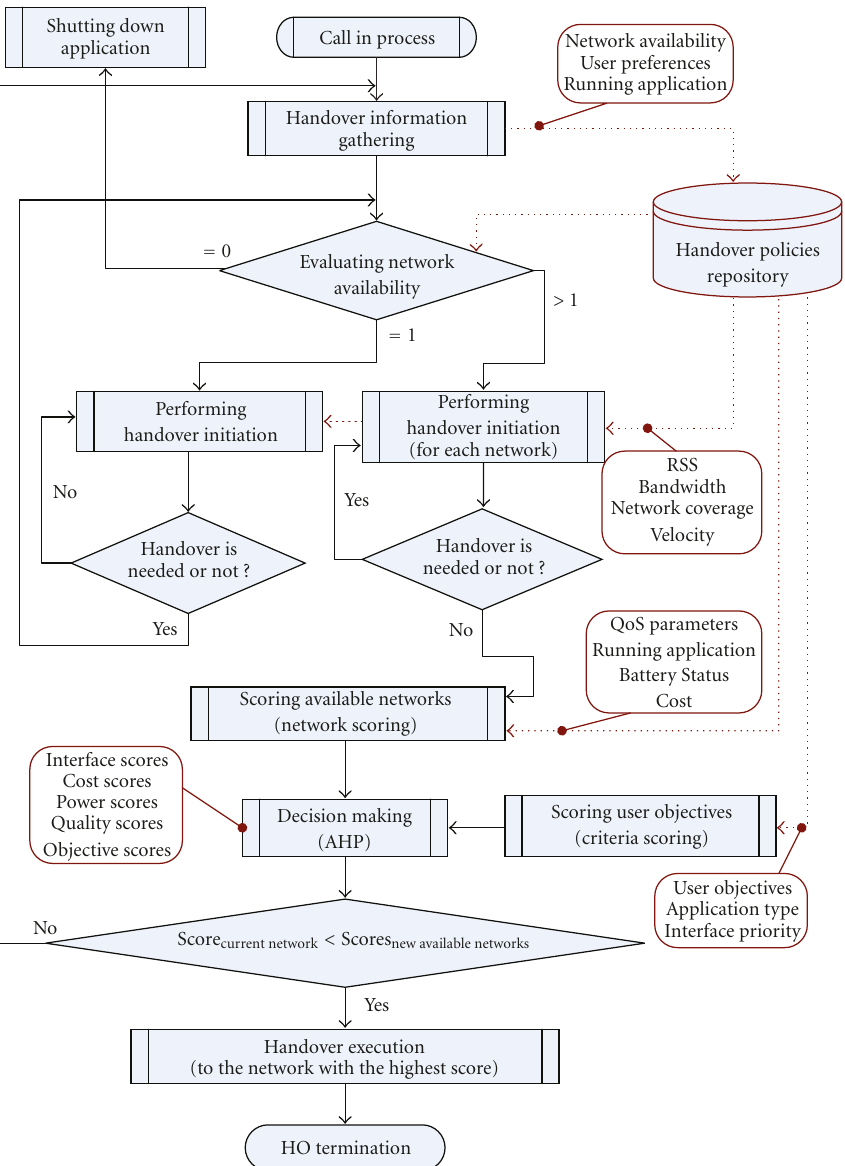
Figure 2: Handover decision process in our handover management system.